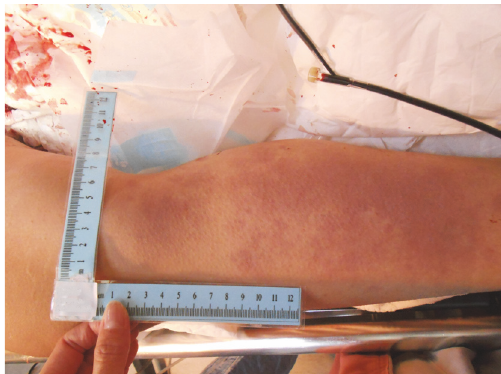
Figure 1: Ecchymosis on calves developed as one of the signs of DIC after uncontrollable